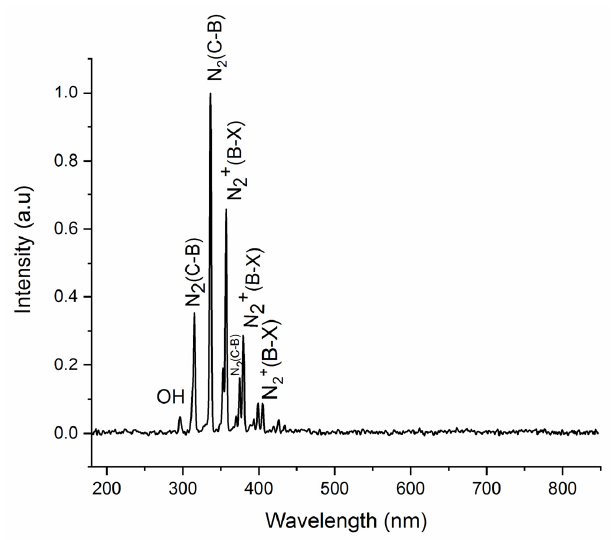
Figure 3. Optical emission spectra of DBD ACP operating in air at 34 kV, 3.5 kHz, 5 mm gap.